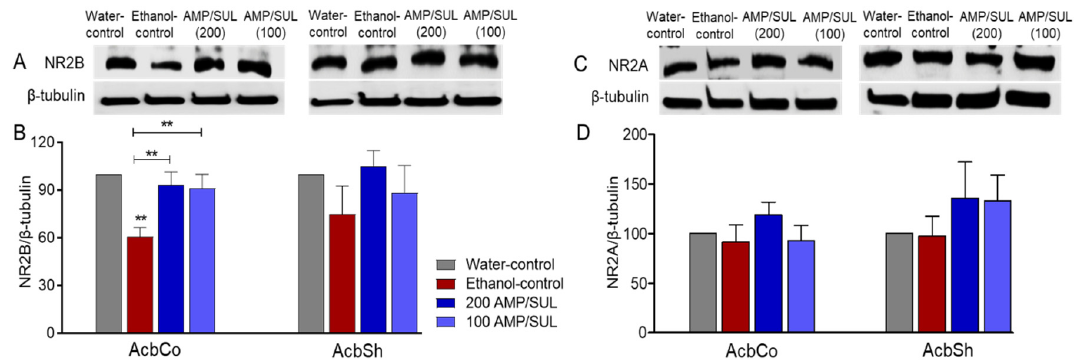
Figure 3. E ff ects of AMP / SUL treatments (100 mg / kg and 200 mg / kg, i.p.) for five days on the expression of NR2B and NR2A in the AcbCo and AcbSh. ( A ) Immunoblot of NR2B and β -tubulin in the AcbCo